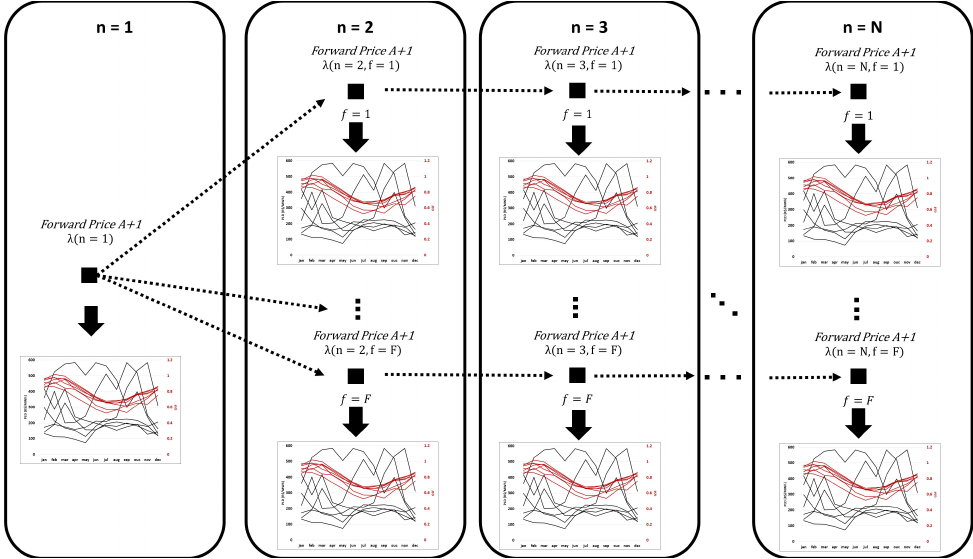
Figure 4. Decision-making process flow chart of a HPP participation in the Brazilian electricity